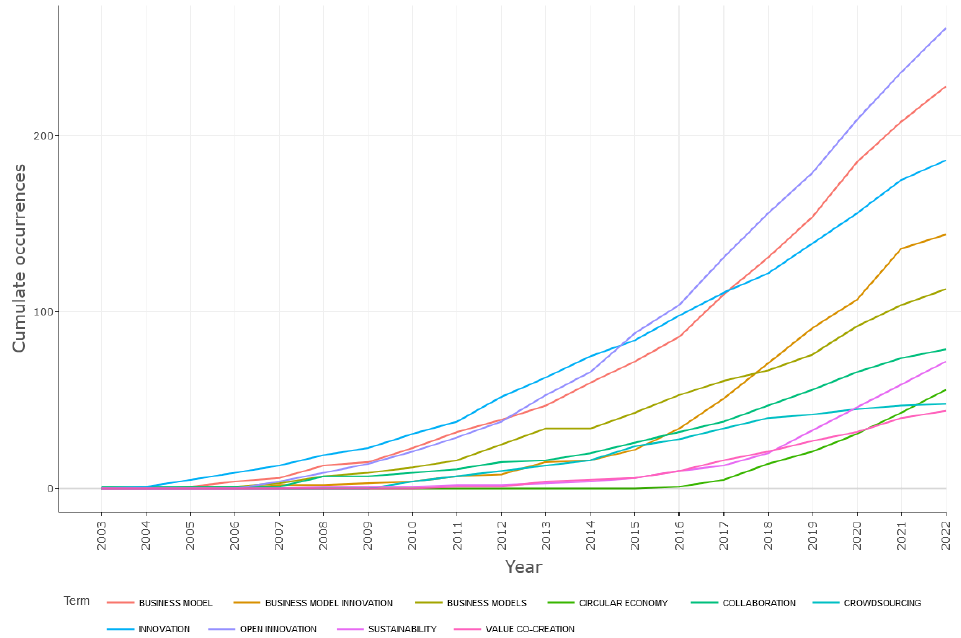
Figure 3. Dynamics of top ten authors’ keywords of the BM&OI.